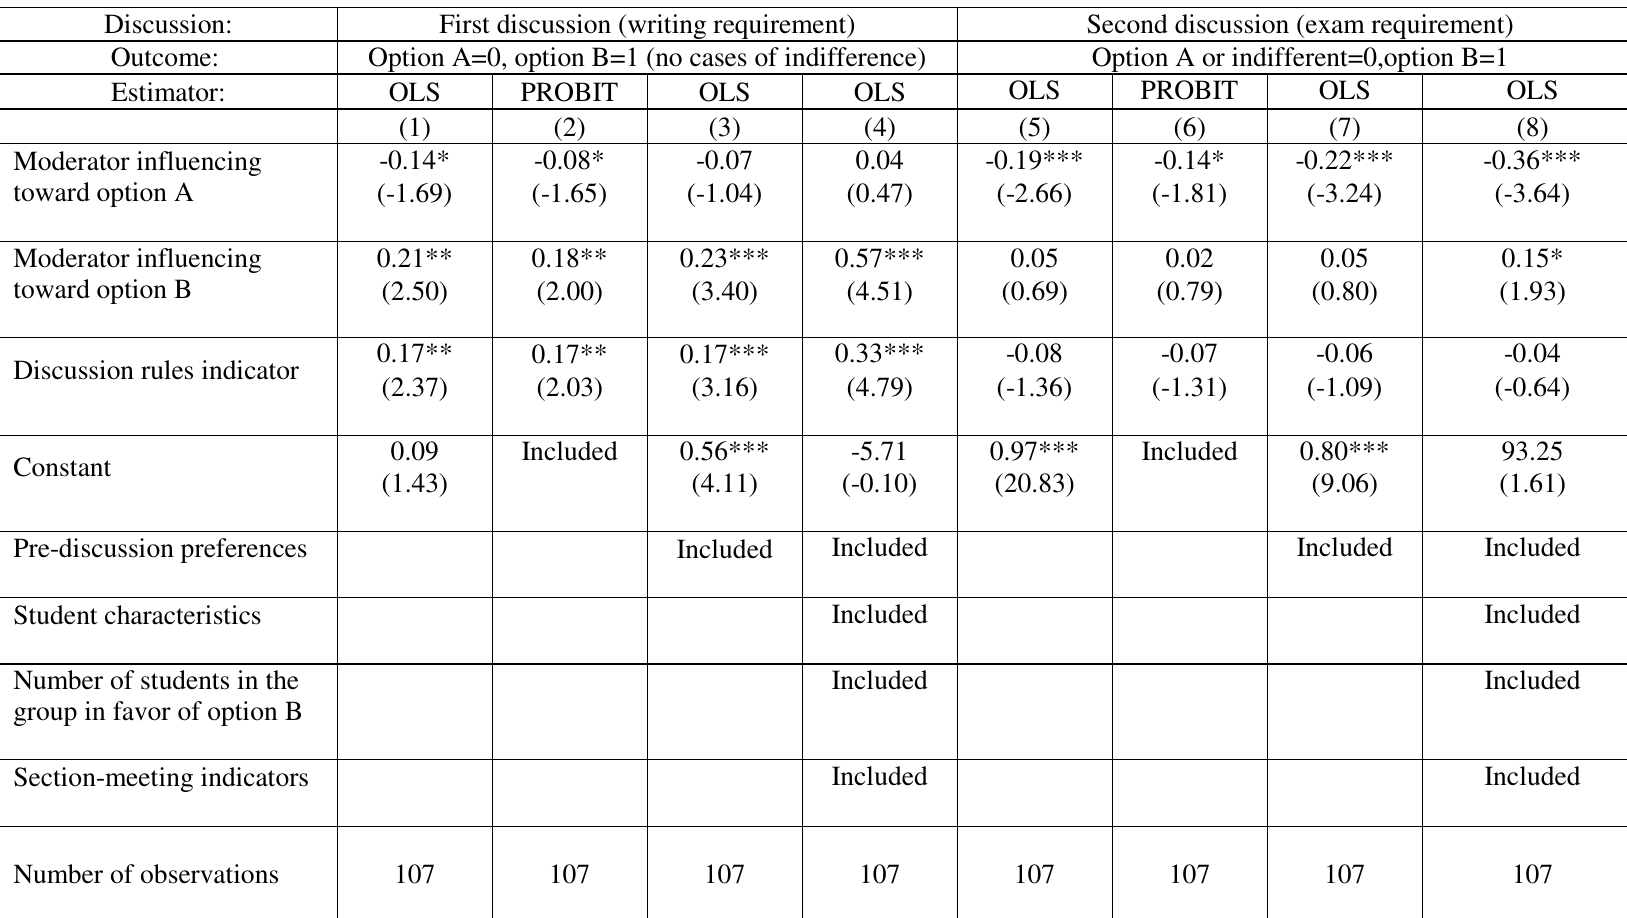
Table 2: The effect of